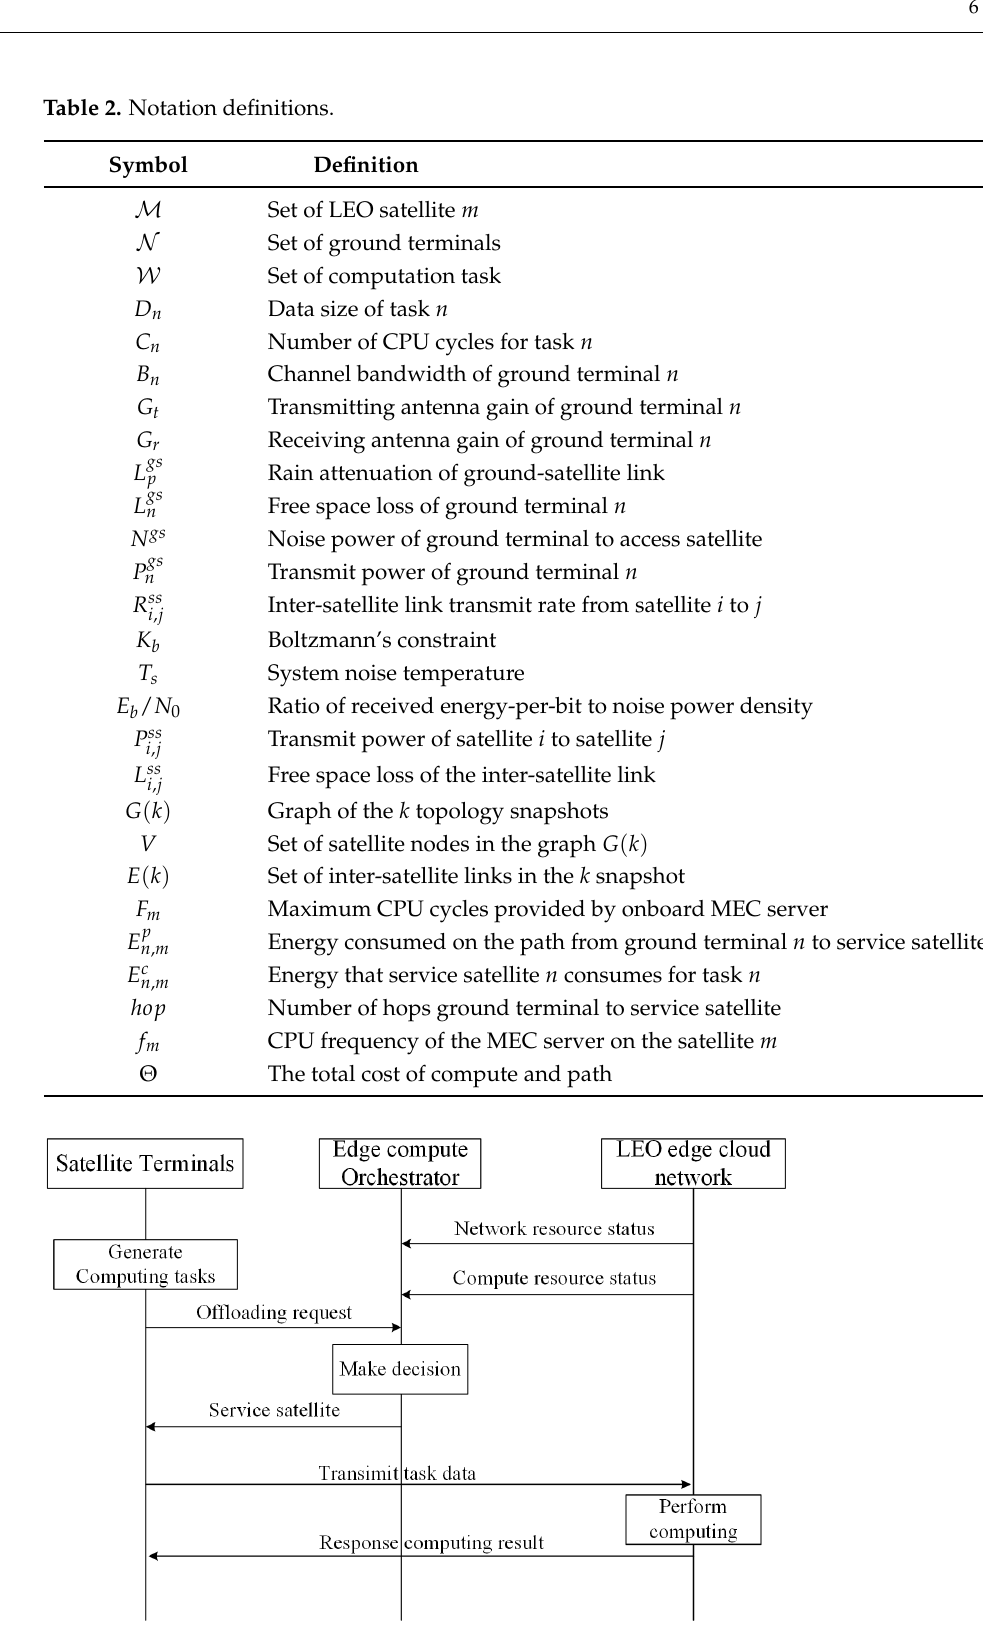
Figure 3. Compute offloading